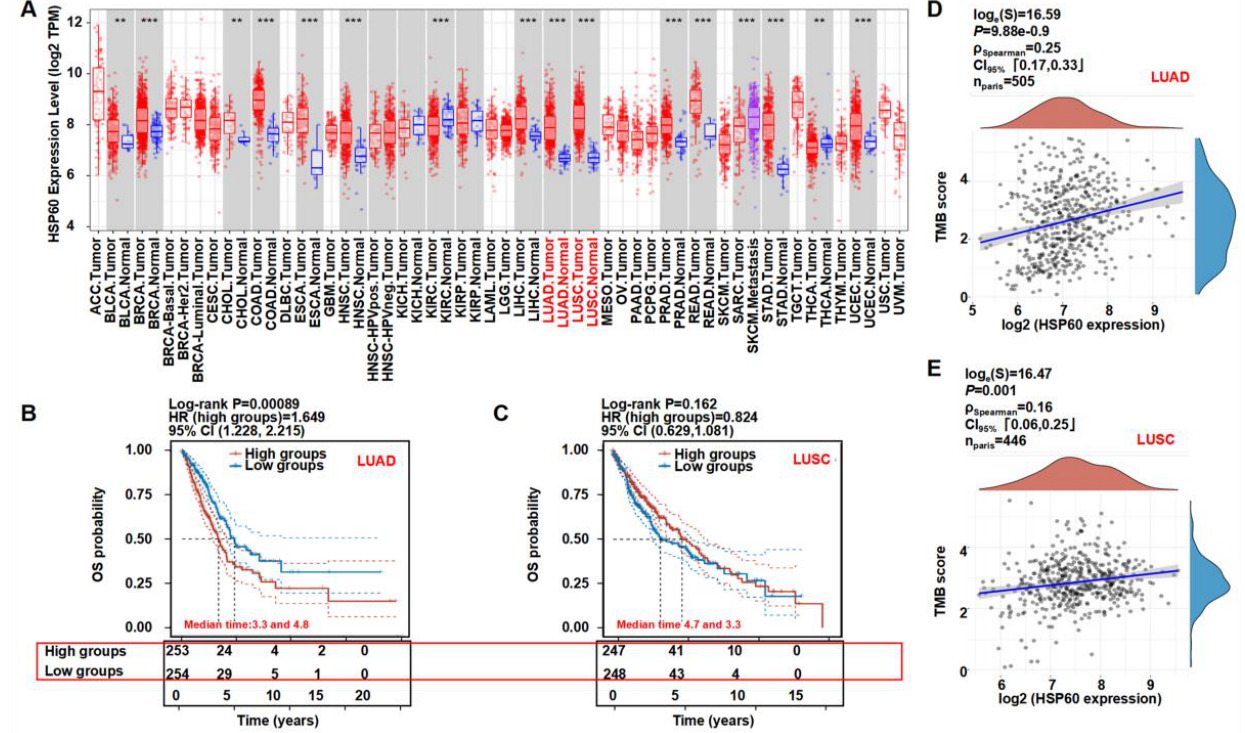
Figure 5. Clinical relevance of HSP60 in lung cancer. ( A ) Diffuse expression analysis of HSP60, ** p < 0.01, *** p < 0.001. ( B , C ) Prognostic analysis of HSP60 in LUAD and LUSC. ( D , E ) Spearman correlation analysis of TMB and HSP60 expression in LUAD and LUSC. p < 0.05 was considered to be statistically significant.